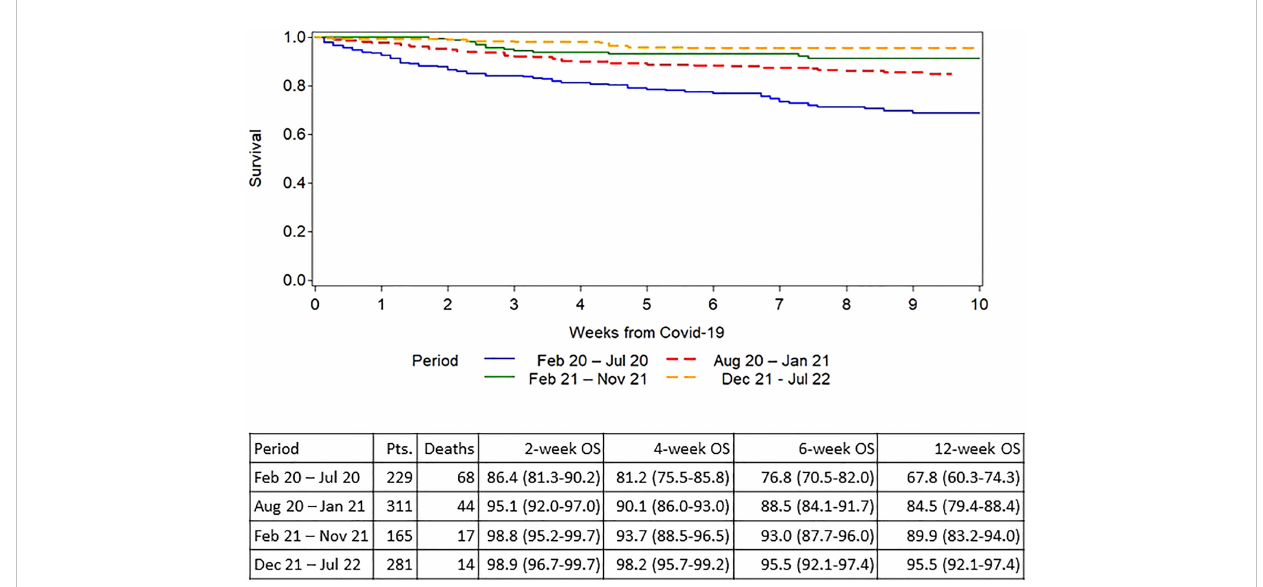
FIGURE 4 Overall survival after diagnosis of COVID-19 in allogeneic HCT recipients split by pandemic